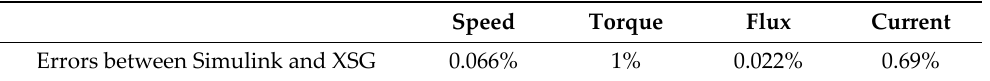
Table 3. Error rate collection between quantities modeled in Simulink and those modeled with XSG. Speed Torque Flux Current Errors between Simulink and XSG 0.066% 1% 0.022% 0.69%